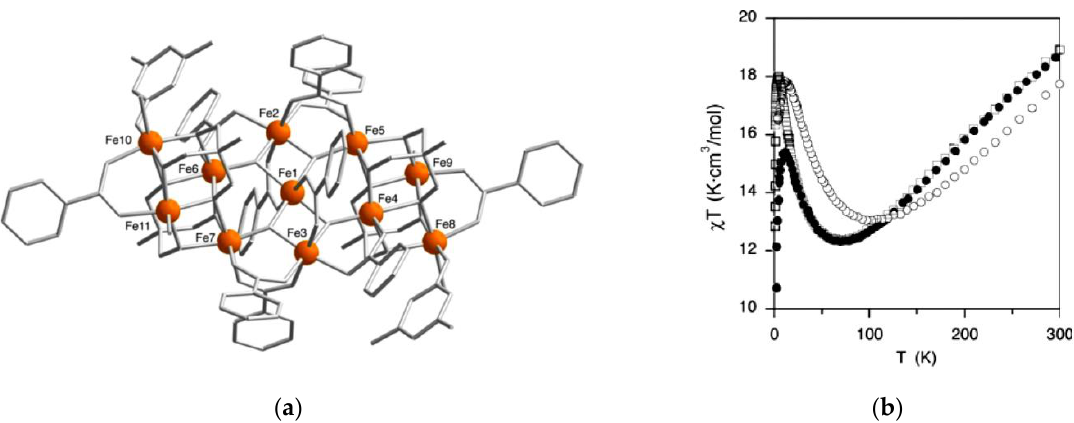
Figure 16. The molecular structure of Fe 11 complex ( a ) and magnetic susceptibility curves ( b ). The black circles and the white circles and squares correspond to experimental data, fitting results from DFT J values and CMC simulations with the calculated values as the starting point, respectively. All hydrogen atoms are omitted for clarity (adapted with permission from [67]).